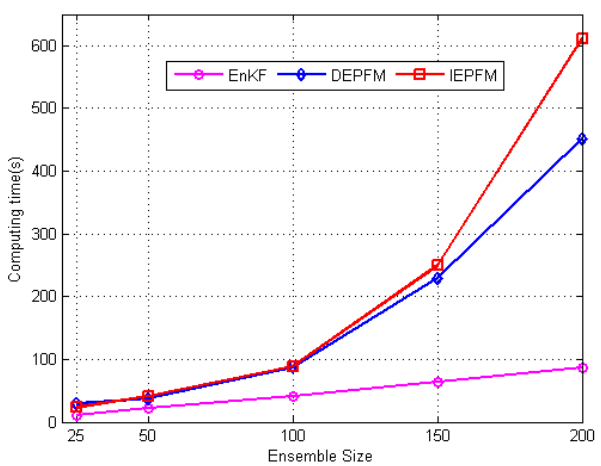
Figure 7. Comparison of the average computation time at different ensemble sizes.